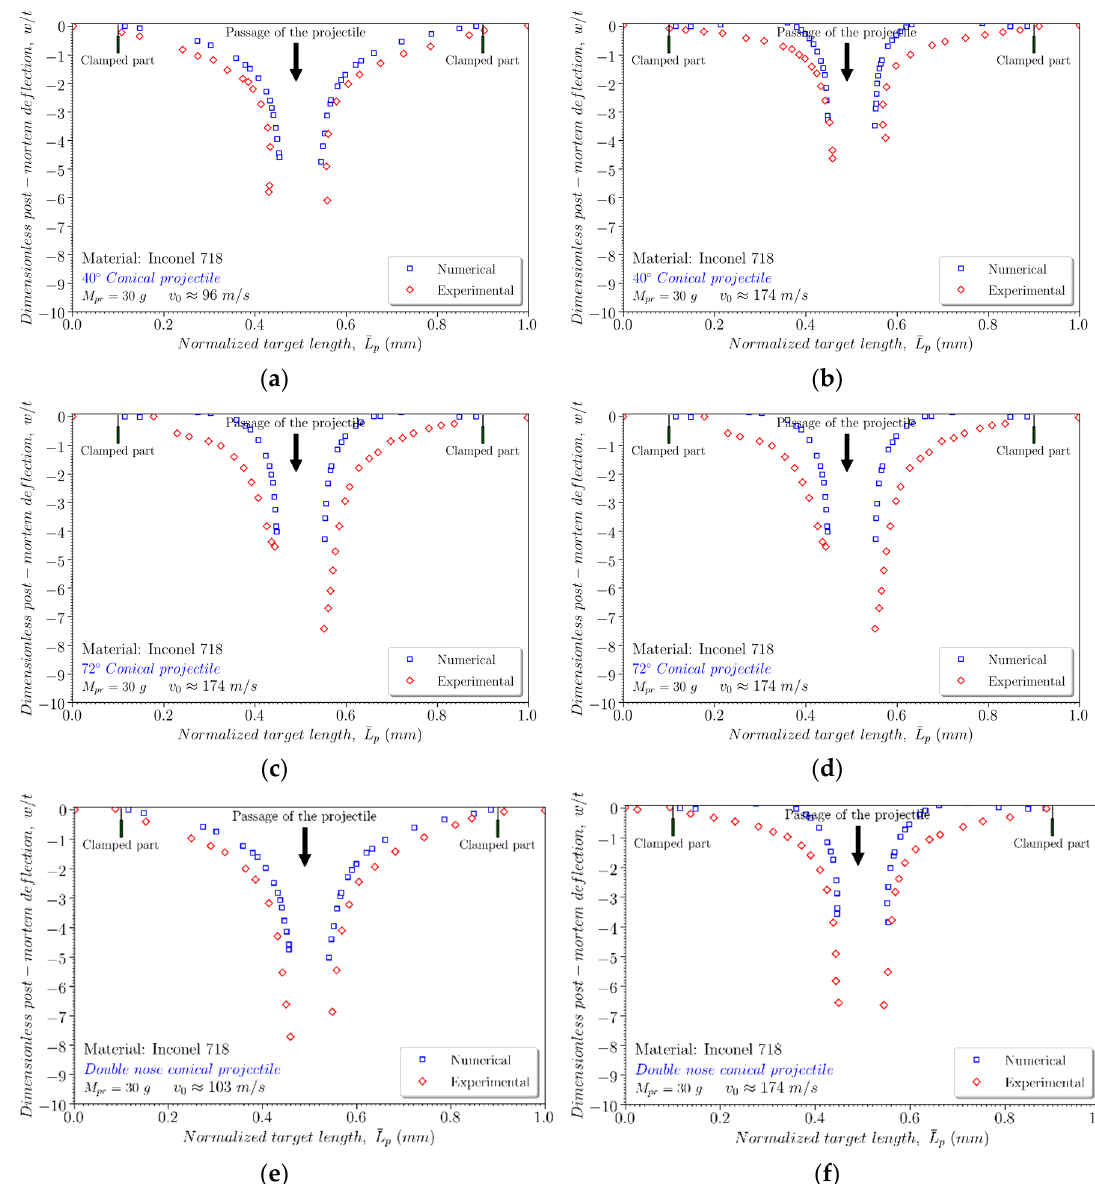
Figure 10. Dimensionless post-mortem deflection vs. the normalized target length for: ( a ) 40° conical projectile at V 0 ∼ 96 m/s; ( b ) 40° conical projectile at V 0 ∼ 174 m/s ; ( c ) 72° conical projectile at V 0 ∼ 108 m/s; ( d ) 72° conical projectile at V 0 ∼ 174 m/s; ( e ) double-nose projectile at V 0 ∼ 103 m/s; and ( f ) double-nose projectile at V 0 ∼ 174 m/s.